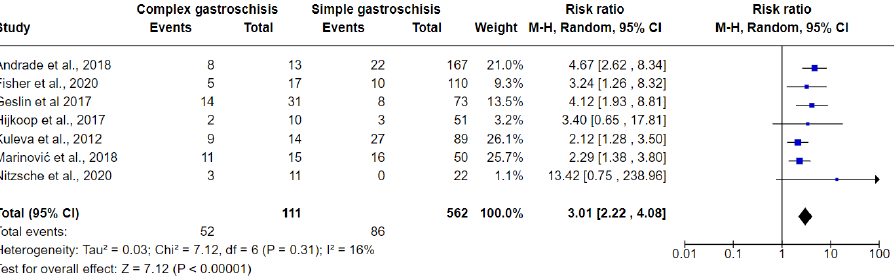
Figure 6. Forest plot between simple and complex gastroschisis for IABD ultrasound markers.